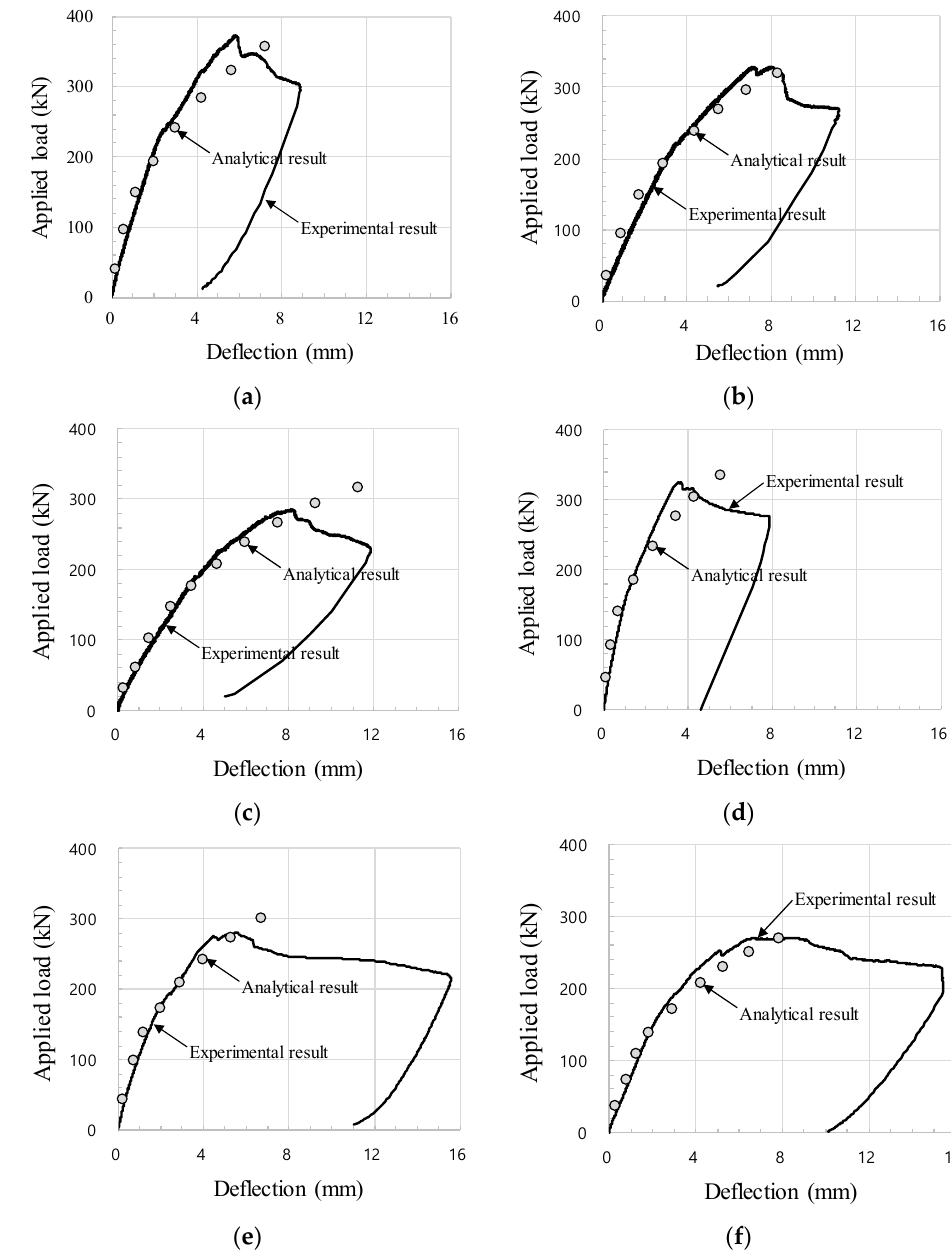
Figure 8. Prediction results for load-deflection relationship of shear-critical RC beams: ( a ) S1-3.0; ( b ) S1-3.5; ( c ) S1-4.0; ( d ) S2-2.5; ( e ) S2-3.0; ( f ) S2-3.5.